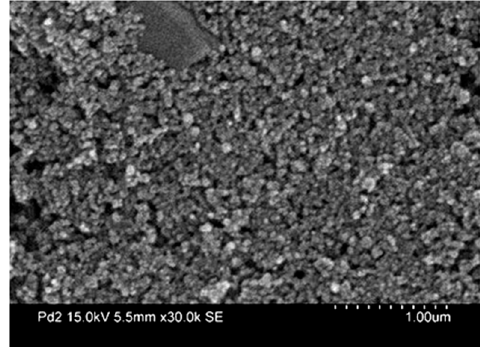
Figure 8. SEM image of PdNPs/SPC TTF E prepared by method B and CV2 conditions.